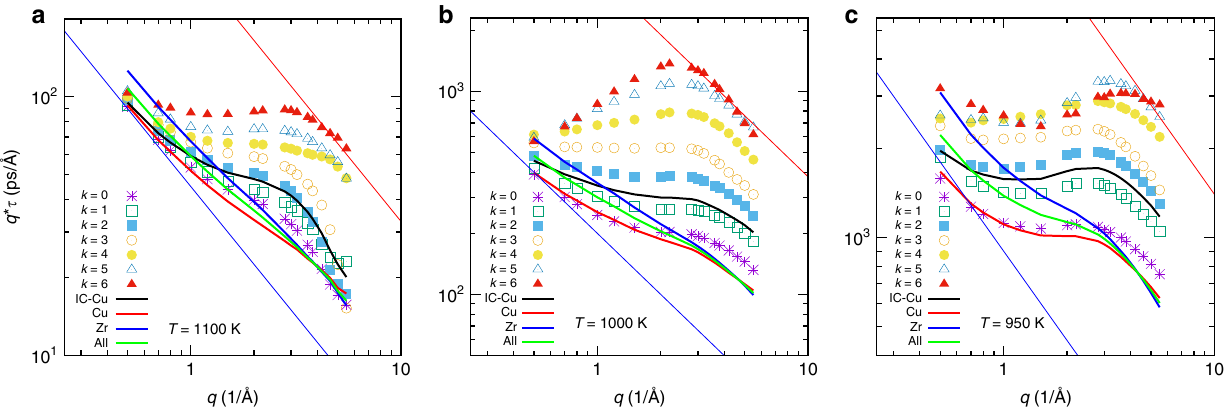
Fig. 4 Wave-vector dependence of the α - relaxation time. We plot τ ( q ) q as a function of q for different values of the connectivity k . Also included is the data for all Cu/Zr atoms and all atoms. The three panels correspond to different temperatures: a T = 1100 K, b T = 1000 K, and c T = 950 K. The solid lines are power-laws with exponent − 1, the q dependence expected for a